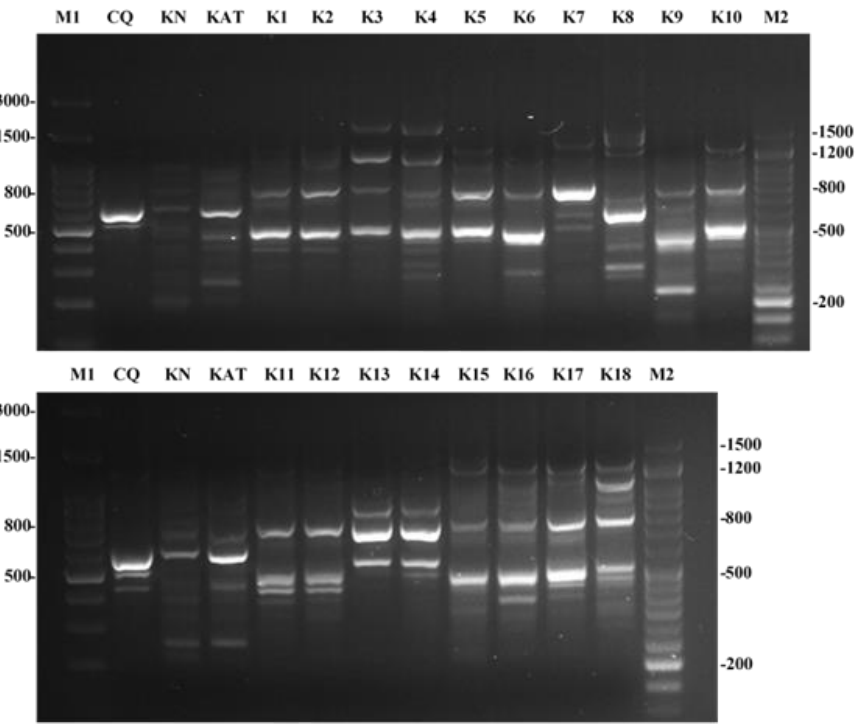
Figure 1. RAPD analysis of both ATCC and clinical strains from ICU. M1: 100 bp ladder; M2: 50